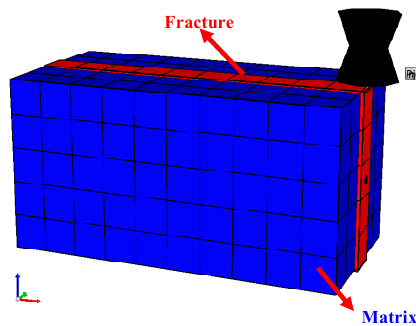
Figure 5. Basic Fracture-Matrix Model in CMG.